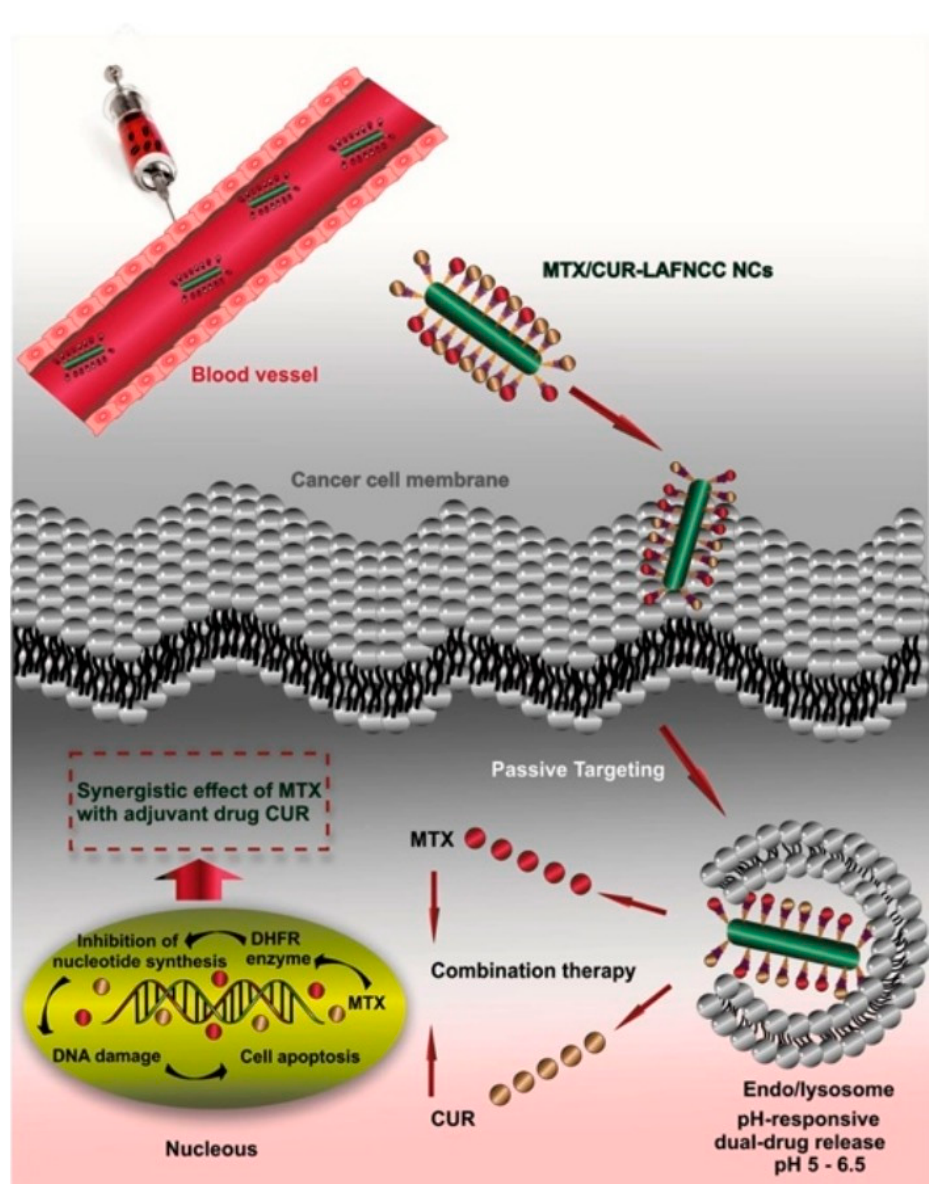
Figure 4. Schematic diagram for dual-drug delivery of a lysine-embedded cellulose-based nanosys- tems. Reproduced with permission from [99], 2020, Elsevier.